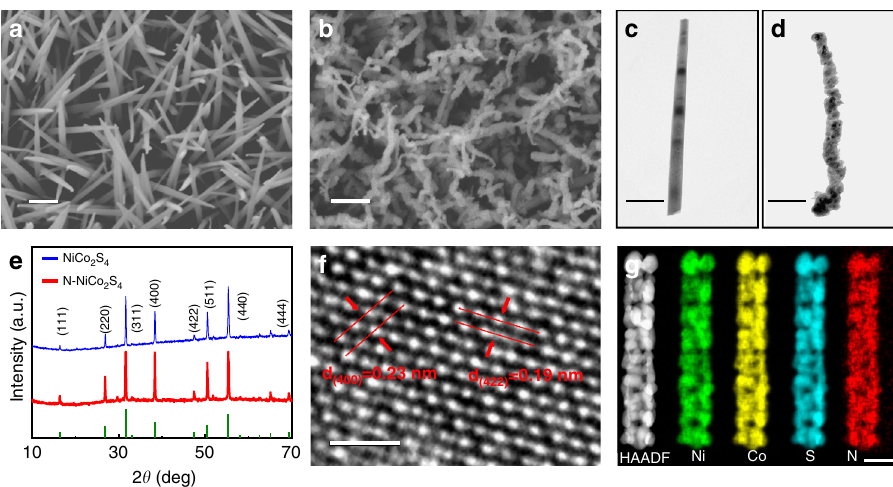
Fig. 2 Morphological and structural characterization. SEM images for a Ni – Co – O and b N – NiCo 2 S 4 nanowire arrays. Scale bar = 400nm. TEM images of c Ni – Co – O and d N – NiCo 2 S 4 nanowires. Scale bar = 200 nm. e XRD patterns of NiCo 2 S 4 and N-NiCo 2 S 4 . f HRTEM image of N – NiCo 2 S 4 nanowire array. Scale bar = 1 nm. g HAADF-STEM image of a single N – NiCo 2 S 4 nanowire and element mapping images of Ni, Co, S, and N elements in the N – NiCo 2 S 4